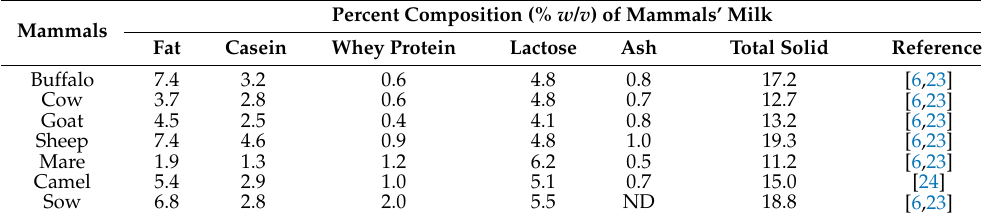
Table 1. Comparison of mammals’ milk